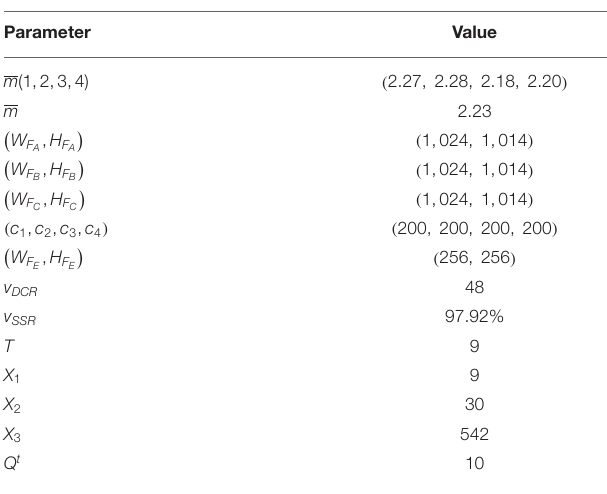
TABLE 6 | Parameter